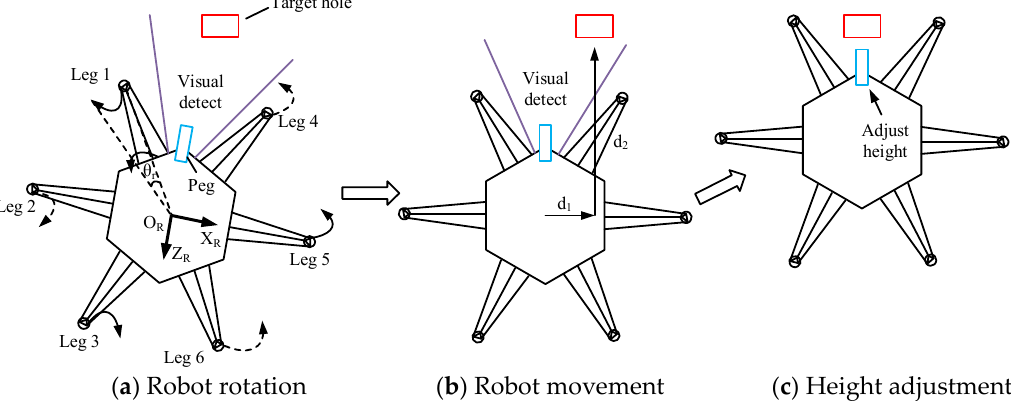
Figure 7. Trajectory planning during the visual locating process.